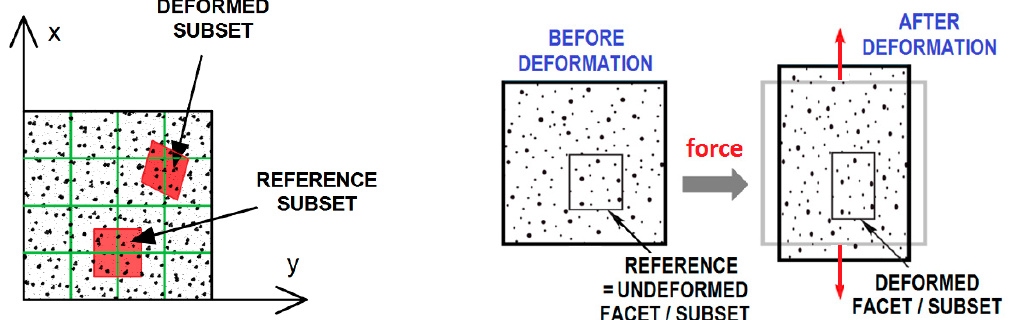
Figure 3. Graphical illustration of the selected region deformation of a scanned surface (a square facet / subset / subimage) in a two-dimensional coordinate system [17,18]. (The Creative Commons